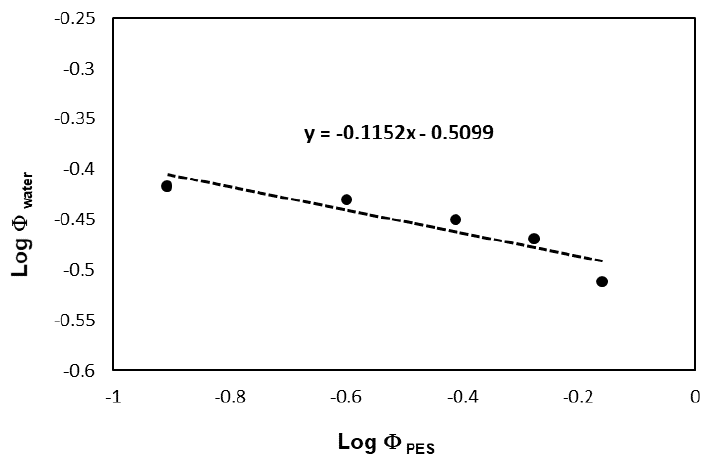
Figure 6. Turbidimetric titration of DMSO-based PES solution (80 min polycondensation time) with water; log volume fraction of water (Log Φ water ) needed to incipient precipitation as a function of the log of the corresponding volume fraction of polyester (Log Φ PES ).